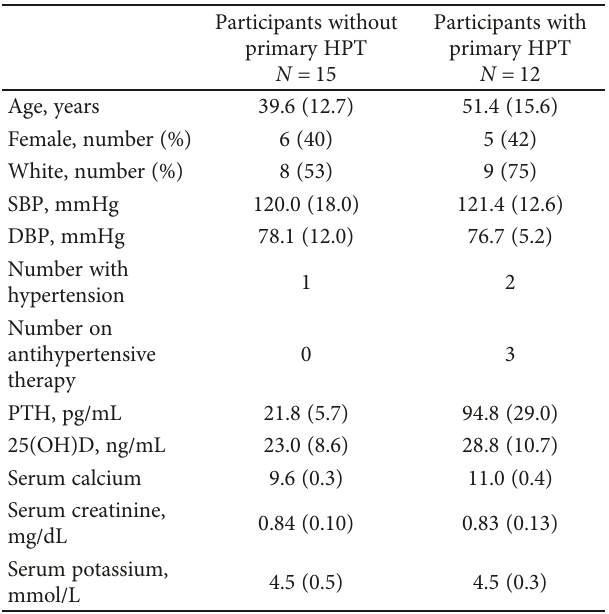
Table 1: Screening demographic and biochemical characteristics of study